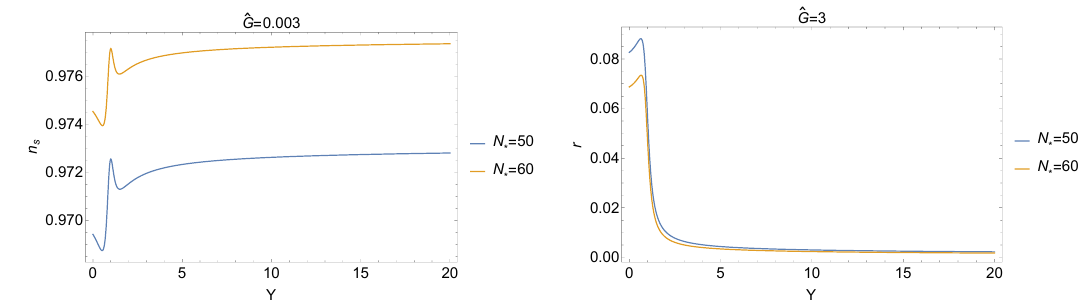
Figure 7 . n s and r in terms of (cid:7) with ^ G = 3 for N (cid:3) = 50 and N (cid:3) = 60 e-folds.